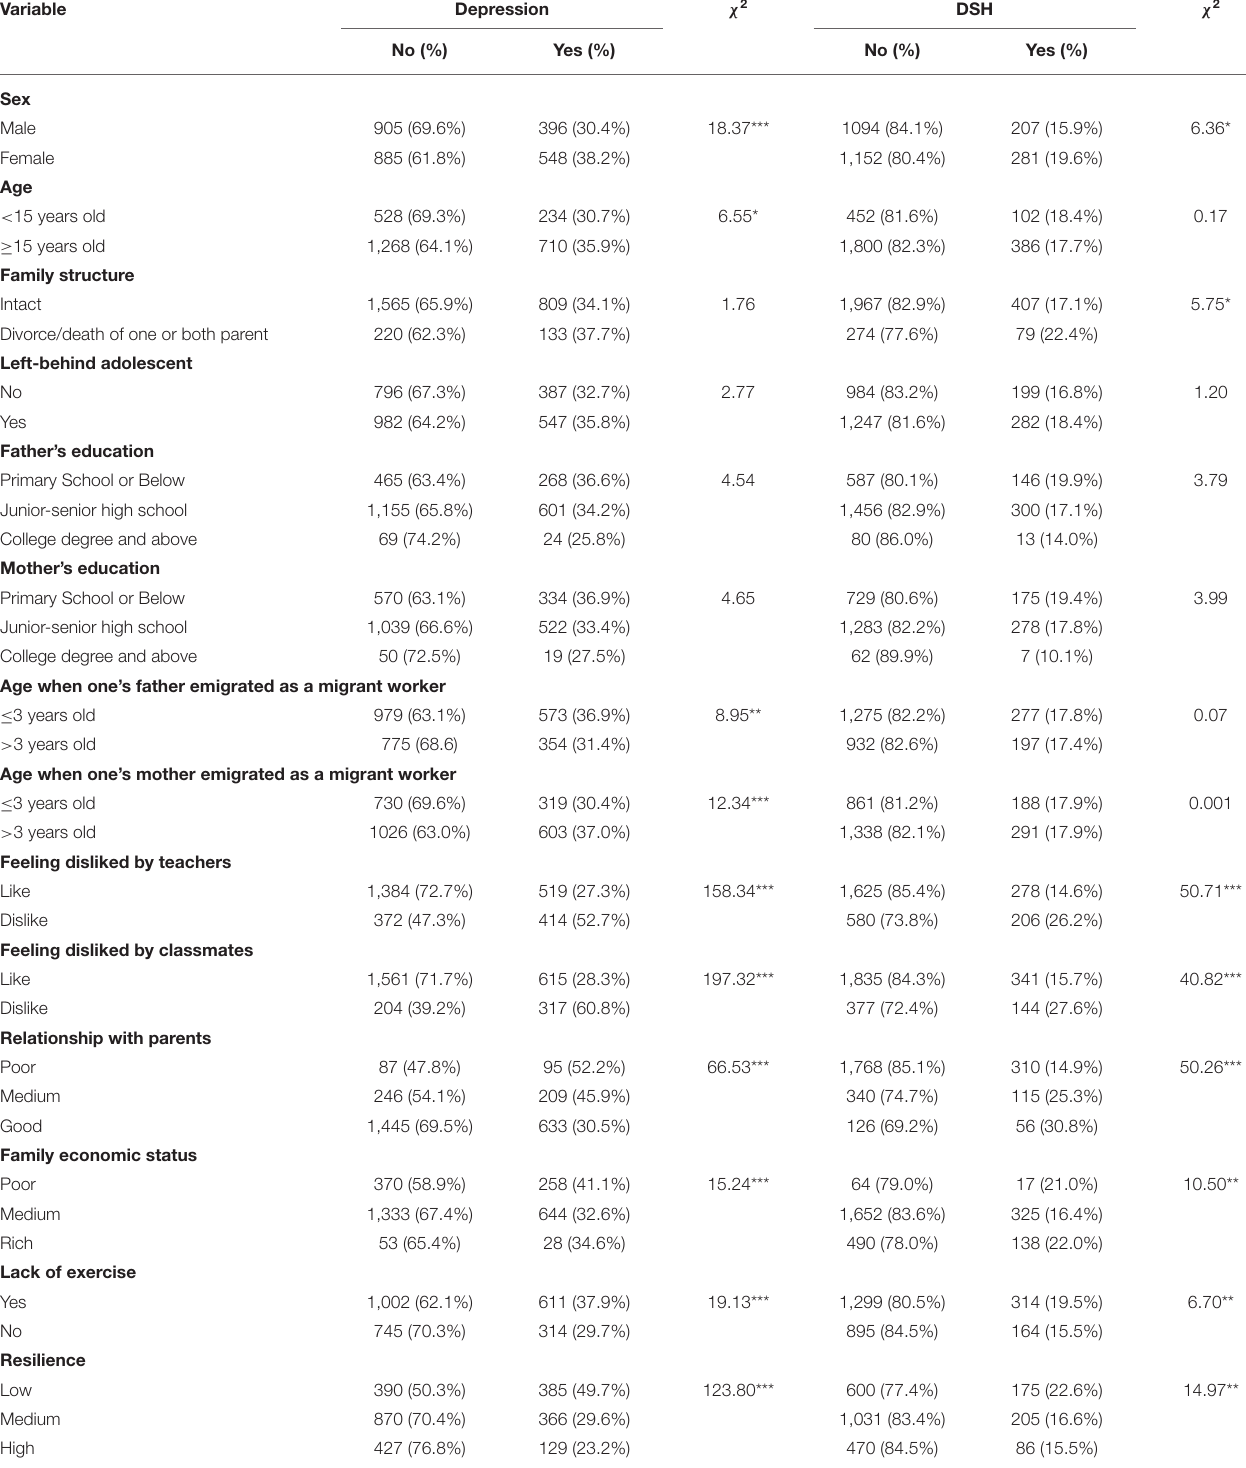
TABLE 2 | Single factor test of depression and